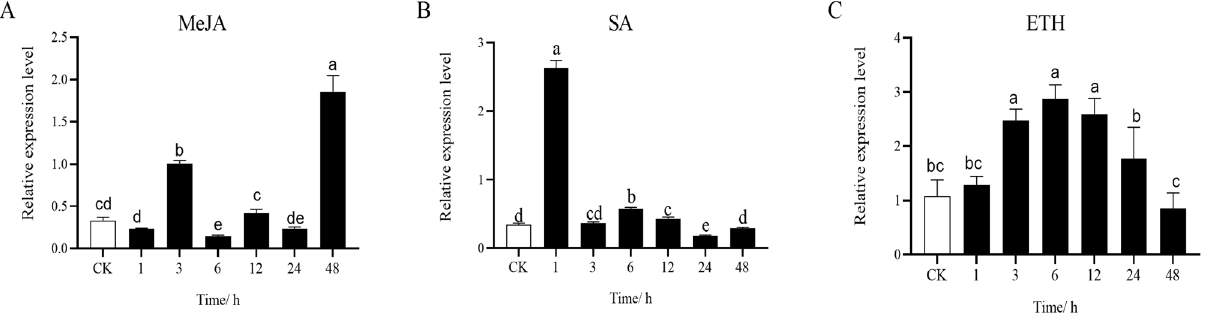
Figure 6. Levels of expression of LhSorPR4-2 after treatment with MeJA ( A ), SA ( B ) and ETH ( C ). Data represent the mean of three biological repeats ± SD. Error bars indicate the standard deviation, and the different lowercase letters (a, b, c, d, e) on the bars indicate the significant differences ( p < 0.05). ETH, Ethephon; MeJA, methyl jasmonate; SA, salicylic acid; SD, standard deviation. Table 2. Cis -acting regulatory element analysis of the LhSorPR4-2 promoter sequence.